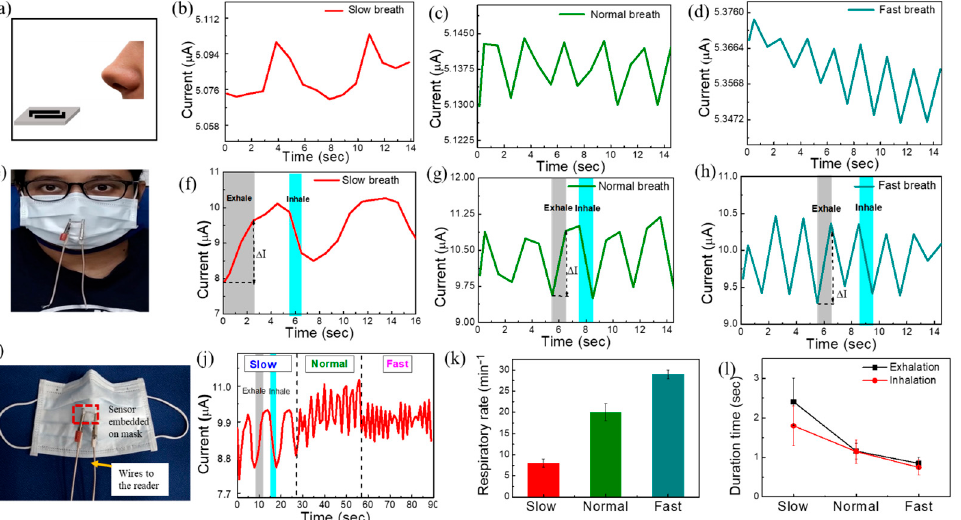
tional flow control or sensing chamber setup. Human breath response to ( b ) slow, ( c ) normal, and ( d ) fast breathing under ambient atmosphere. ( e ) The image of human wearing sensor-embedded mask. Human breath responses curve to ( f ) slow, ( g ) normal, and ( h ) fast breathing after wearing mask (sensor 1 cm far from nose). ( i ) Image of ultra-flexible sensor embedded on smart mask. ( j